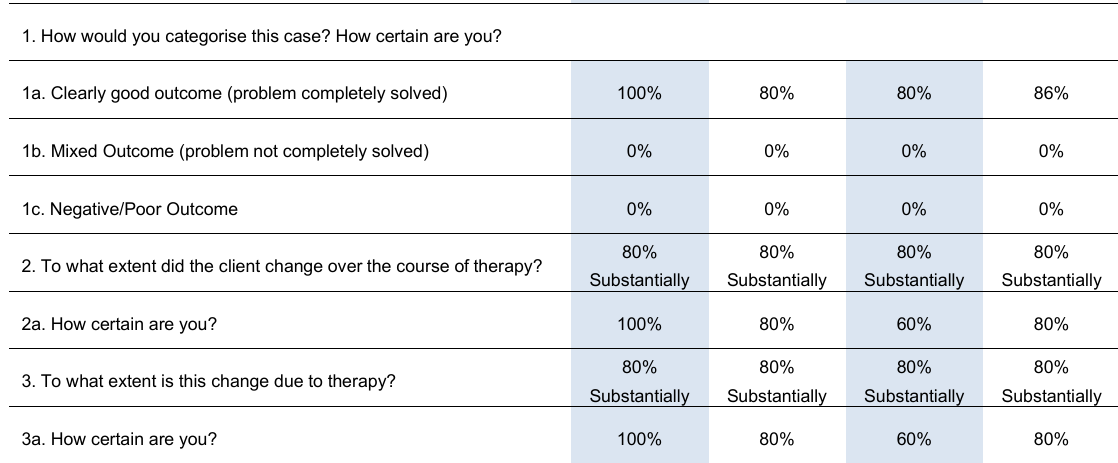
Table 3: Adjudication